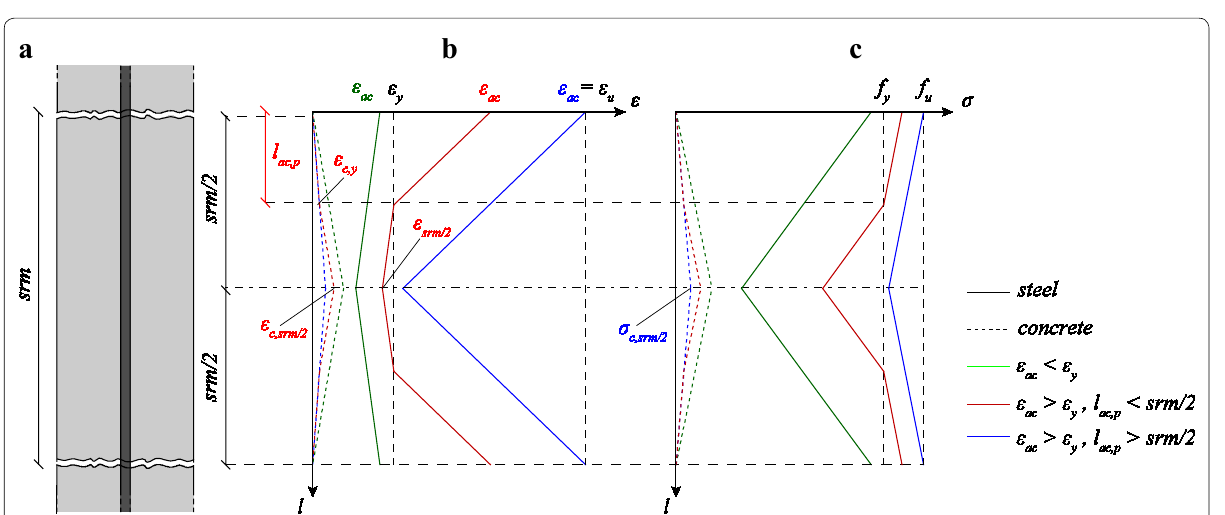
Fig. 5 Basic tension chord element: a Sketch. b Qualitative steel and concrete strain profile. c Qualitative steel and concrete stress